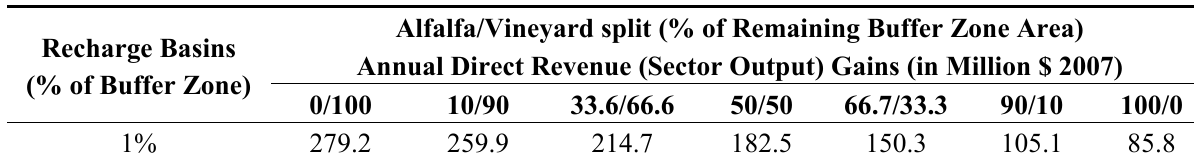
Table 6. Direct revenue in alternative recharge buffer zones at varying recharge basin areas and for various combinations of alfalfa/vineyard splits in a 1000 m land use buffer (compare to Table 4 for current revenue).